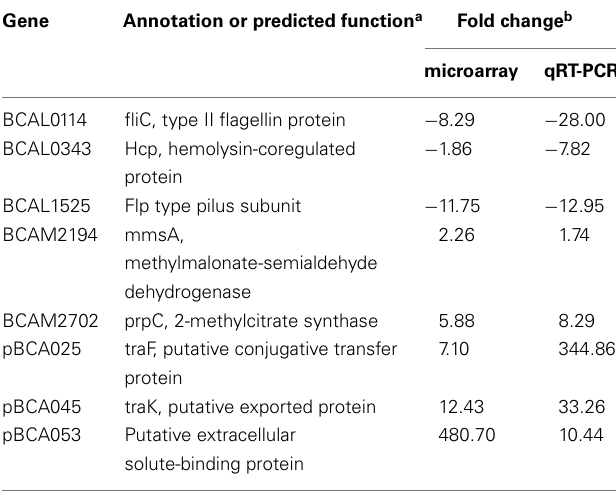
FIGURE 3 | In vivo expression of motility and pilus genes. Expression ratio of RNA recovered from rat lungs ( in vivo ) relative to RNA isolated from in vitro grown cultures as determined by microarray analysis. (A) Flagellar-associated